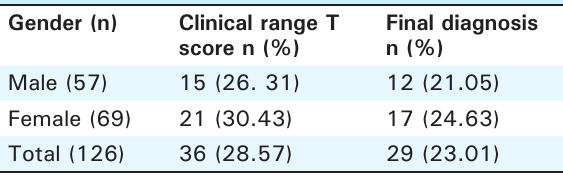
Table 7. Distribution of problem based on gender. Gender (n) Clinical range T Final diagnosis score n (%) n